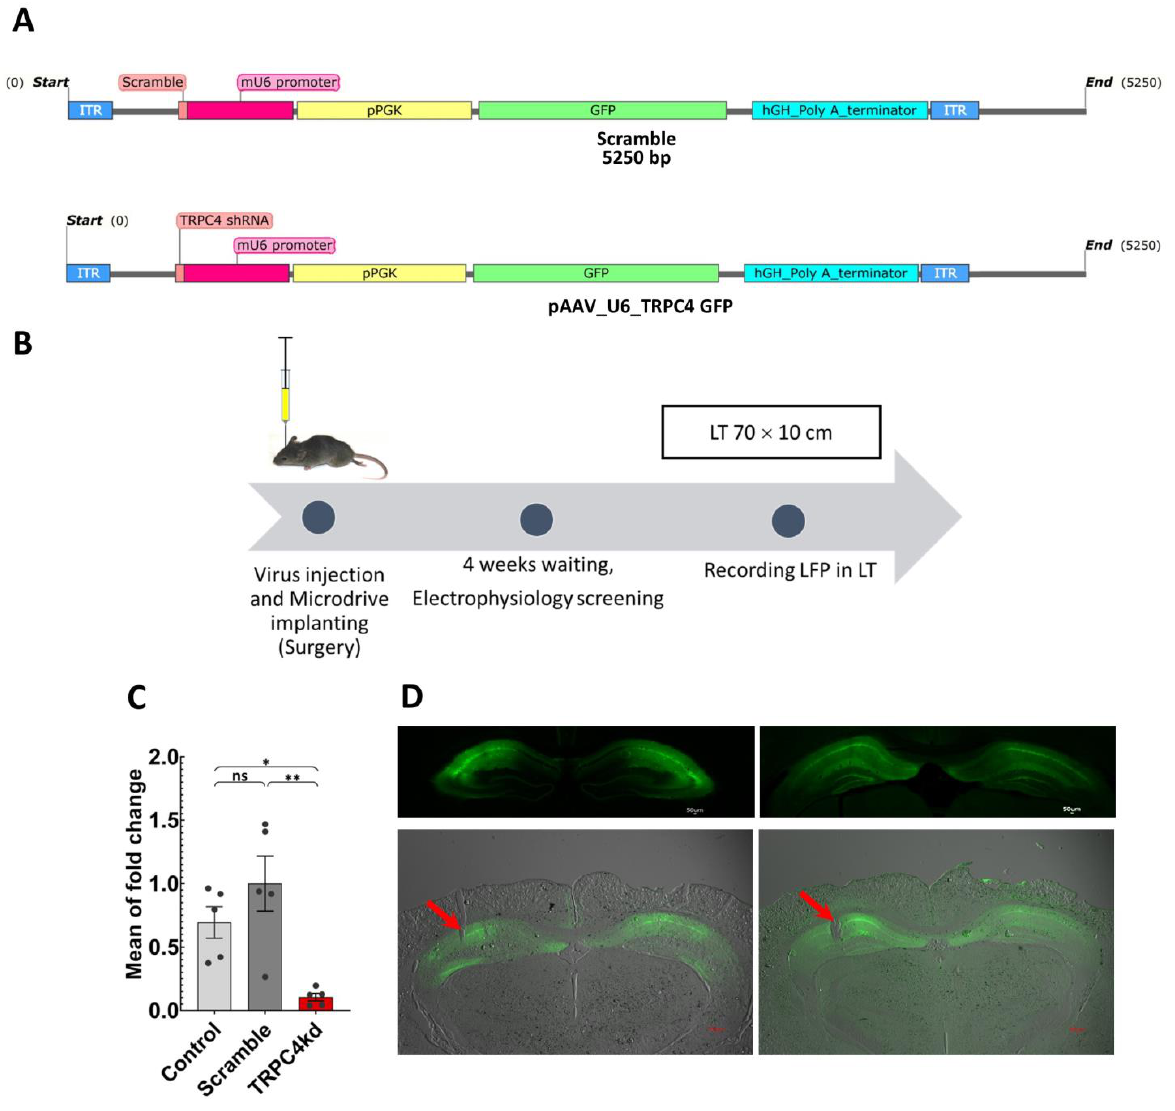
Figure 1. ( A ) Schematic of the AAV scramble virus (top) and TRPC4 KD virus (bottom) showing the promoter, shRNA, and GFP (SnapGene software 6.0.5 (www.snapgene.com)). ( B ) Time chart of the experimental steps from surgery until recording. ( C ) Fold change in TRPC4 expression in primary hippocampal cell culture. The TRPC4 expression was verified using RT-qPCR on day 14 after AAV delivery on day 7 (ANOVA, p < 0.01 between scramble and TRPC4 KD, p < 0.05 between control and TRPC4 KD, n = 5 for control, n = 5 for scramble, n = 5 for TRPC4 KD). ( D ) Viral expression in the mouse hippocampus. Top , GFP expression in the hippocampal coronal sections after scramble (Left) or TRPC4 KD AAV (Right) injection in the CA1 region. Bottom , Microdrive implant control. An example of the tetrodes tip lesion is visible on the left side of the images. Examples of tetrode re- cording sites in scramble (Left) and TRPC4 KD AAV (Right) injected mice. The red arrows show the lesions made by tetrode tips. The acronyms are LT: linear track; LFP: local field potentials. *: p <0.05, **: p <0.01, ***: p <0.001, ns: not significant. 2.2. Animals All mice were cared for and treated strictly following the ethical animal research standards defined by the Directive of the European Communities Parliament and Council